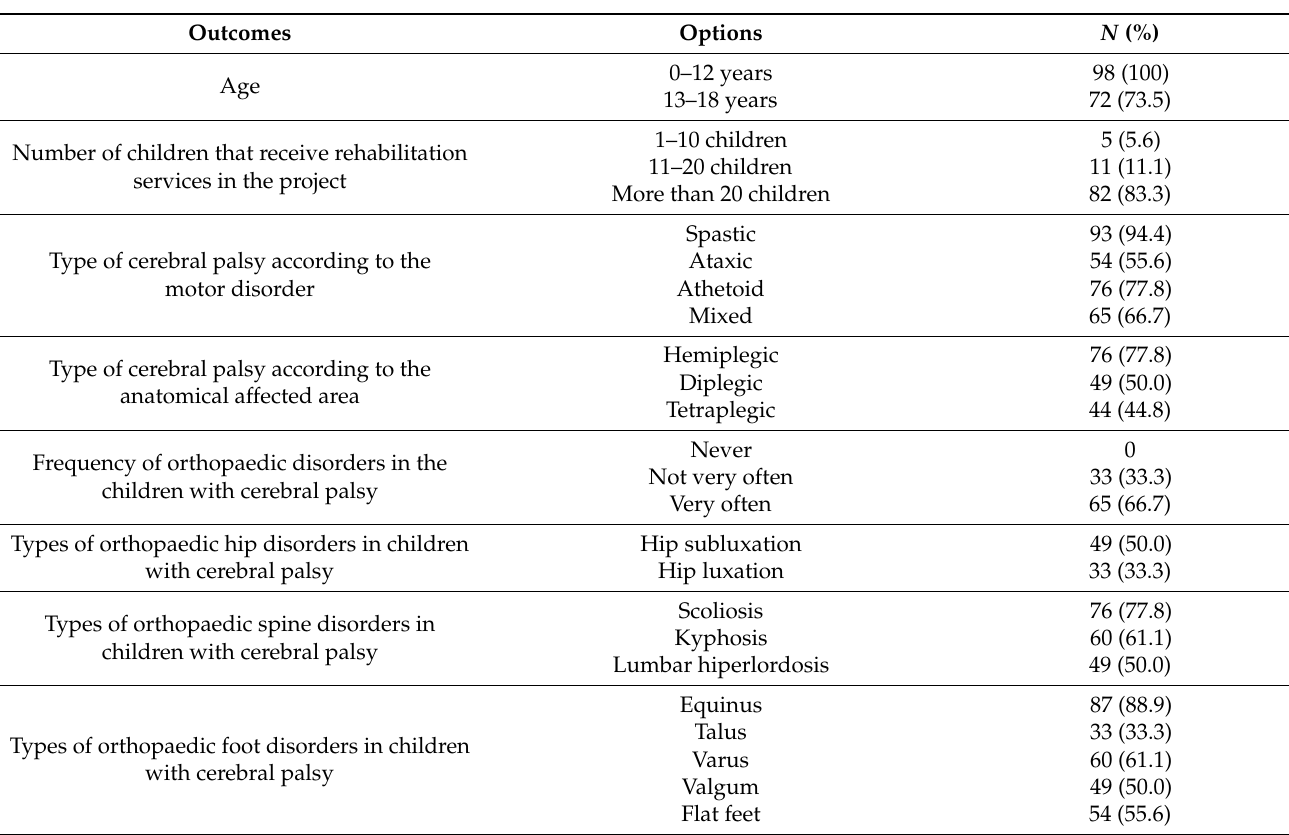
Table 2. Characteristics of the patients, type of cerebral palsy and types of associated orthopaedic